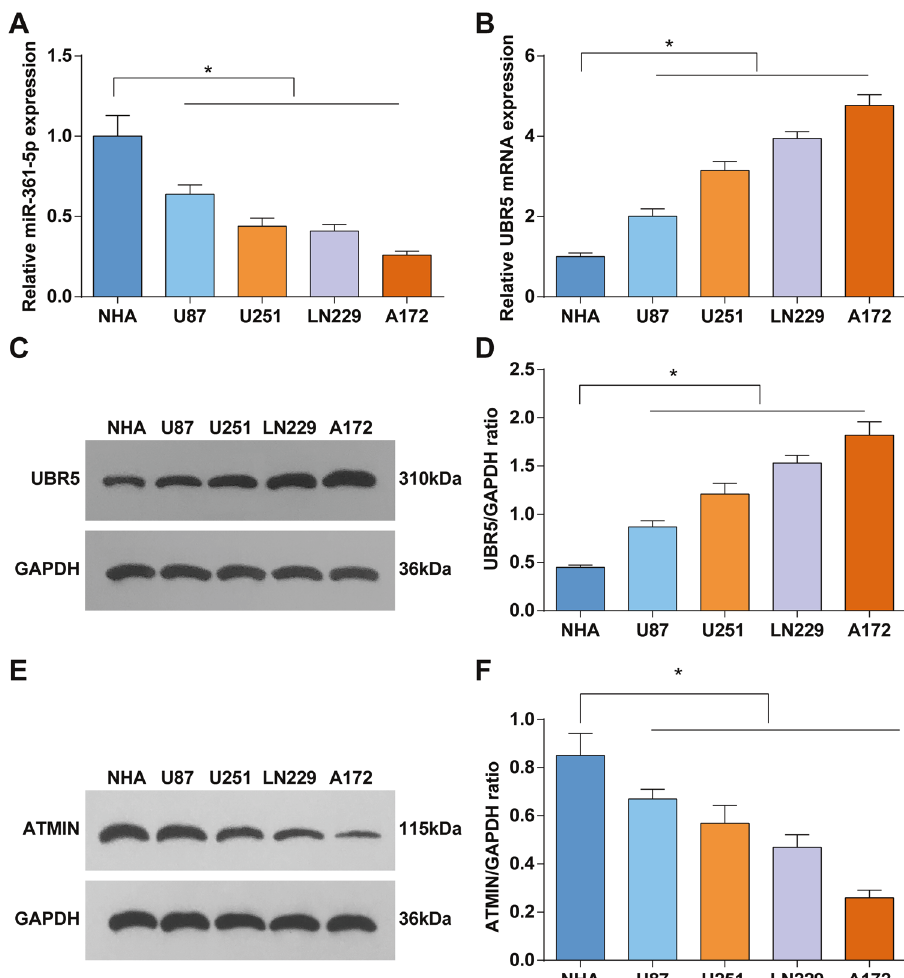
Fig. 2 Reduced miR-361-5p and ATMIN and enhanced UBR5 levels show in gliomas cells. A RT-qPCR tested miR-361-5p expression in gliomas cell lines and NHA. B RT-qPCR tested UBR5 mRNA expression in gliomas cell lines and NHA. C , D Western blot tested UBR5 protein expression in gliomas cell lines and NHA. E , F Western blot tested ATMIN protein expression in cells. The data were all measurement data, in the form of mean ± standard deviation. * P < 0.05 compared with